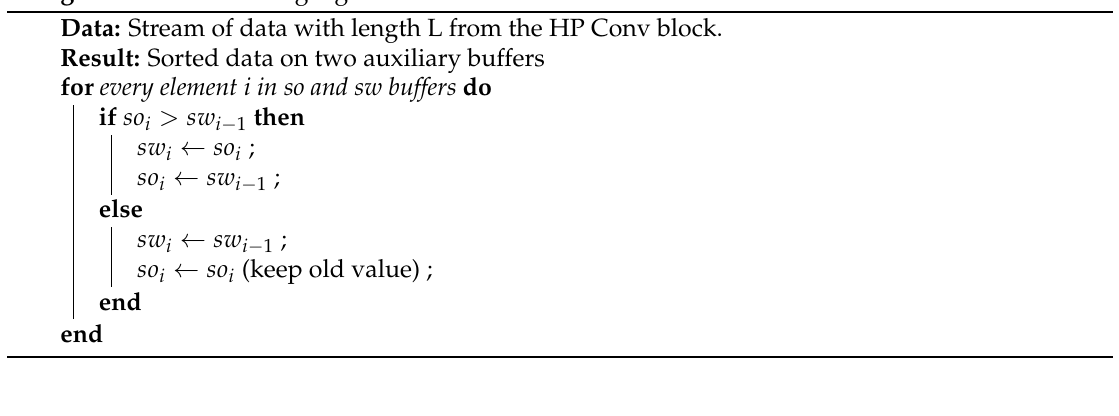
Algorithm 1: The sorting algorithm on so and sw buffers. Data: Stream of data with length L from the HP Conv block.